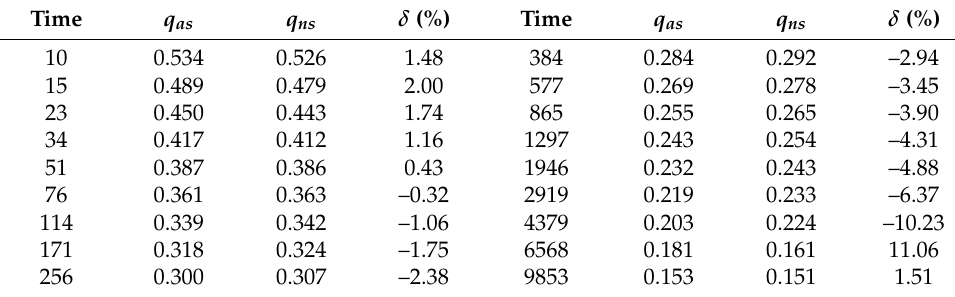
Table 3. Comparison of calculated results under close